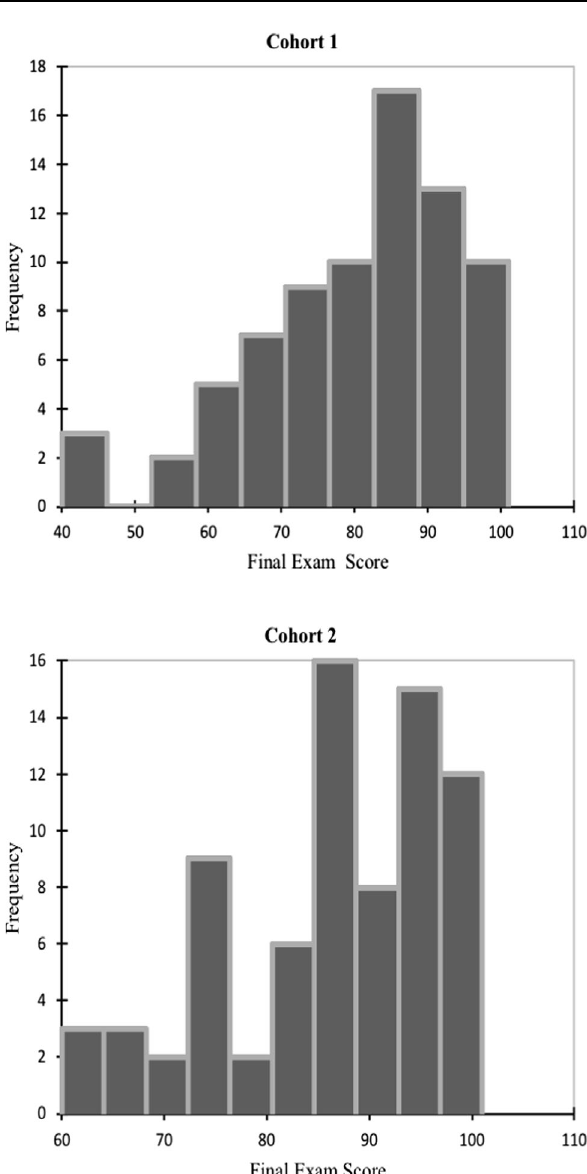
Fig. 1 Histogram of final exam performance in Cohort 1